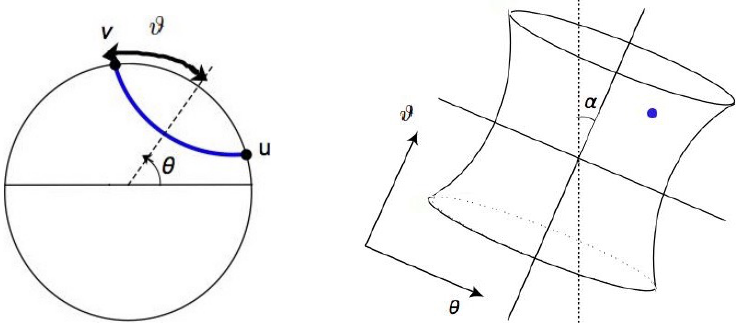
Figure 8 . The geodesic and the corresponding point in the kinematic space are shown in blue color. Also, the angles # , (cid:18) and (cid:11) in relation (5.48) for the warped AdS 3 case are shown. However, the tilt angle (cid:11) introduced in relation (5.47) which should be (cid:12)xed by the theory and is \not" an arbitrary parameter of warped AdS backgrounds, would not necessarily have the exact geometrical meaning shown